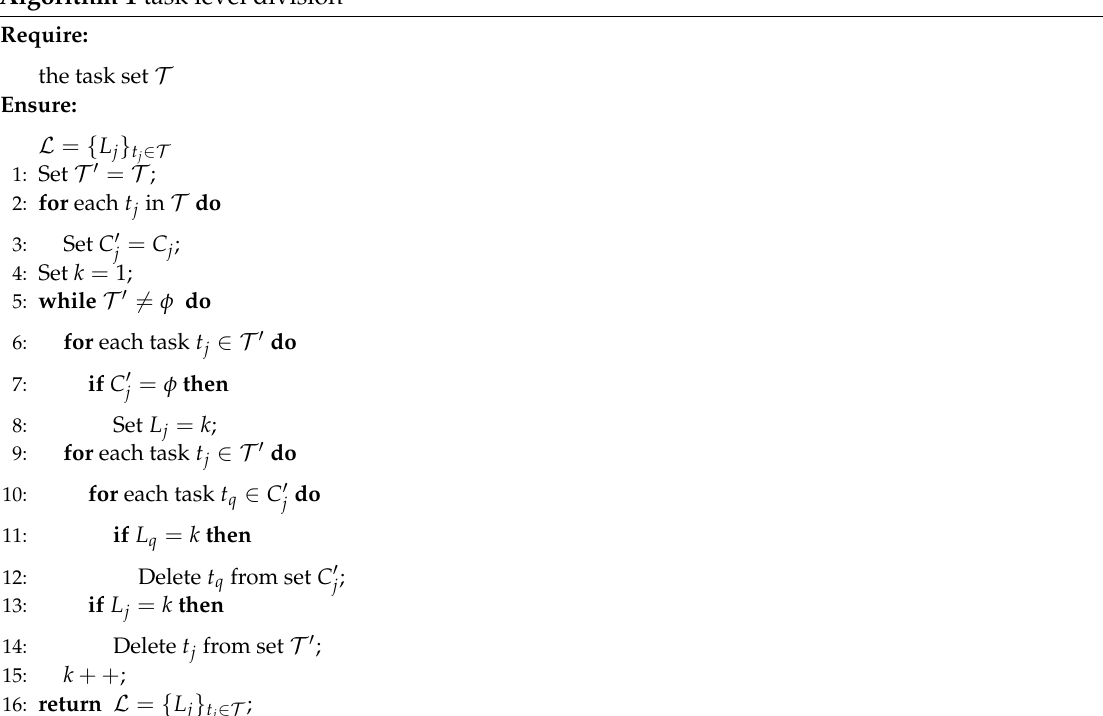
Algorithm 1 task level